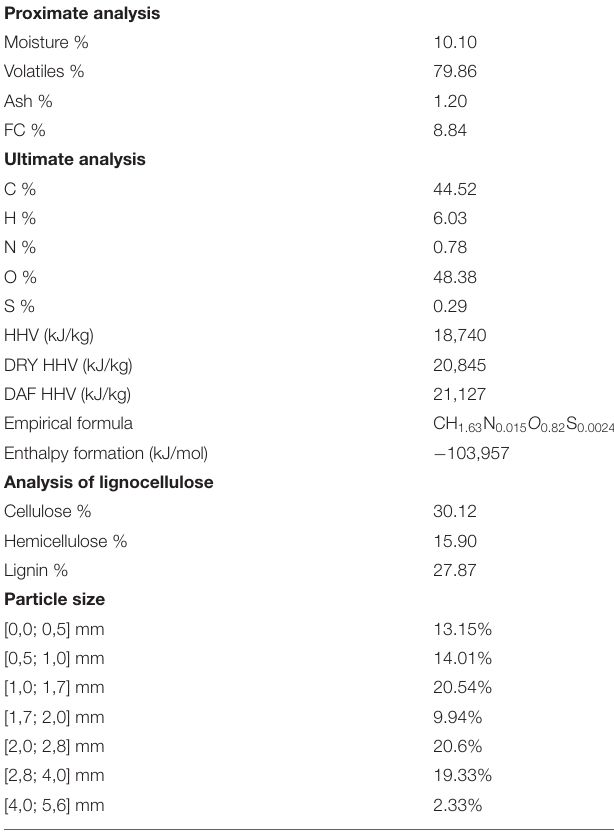
TABLE 3 | Characterization of